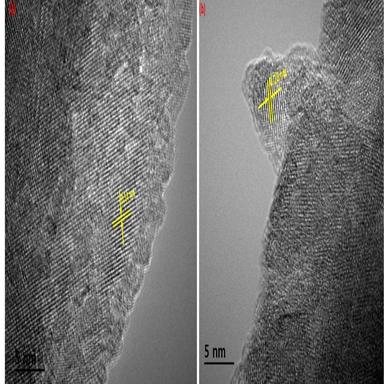
TEM images of nanocomposite materials having different resolutions (a) Au0 (NPs)/TiO2; and (b) Au0 (NPs)/TiO2(T).